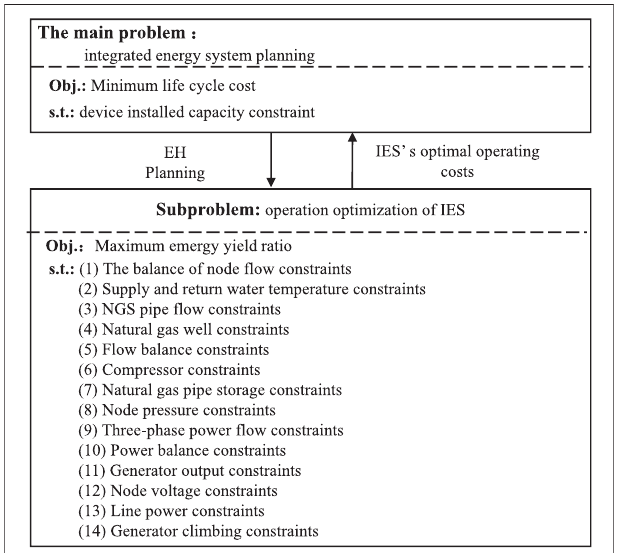
FIGURE 3 | EH bi-level programming model